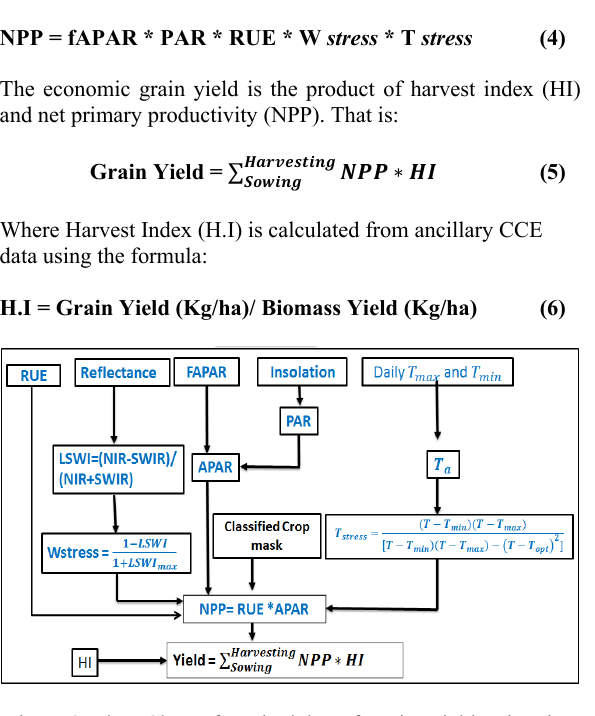
Figure 2: Flow Chart of Methodology for Rice yield estimation using